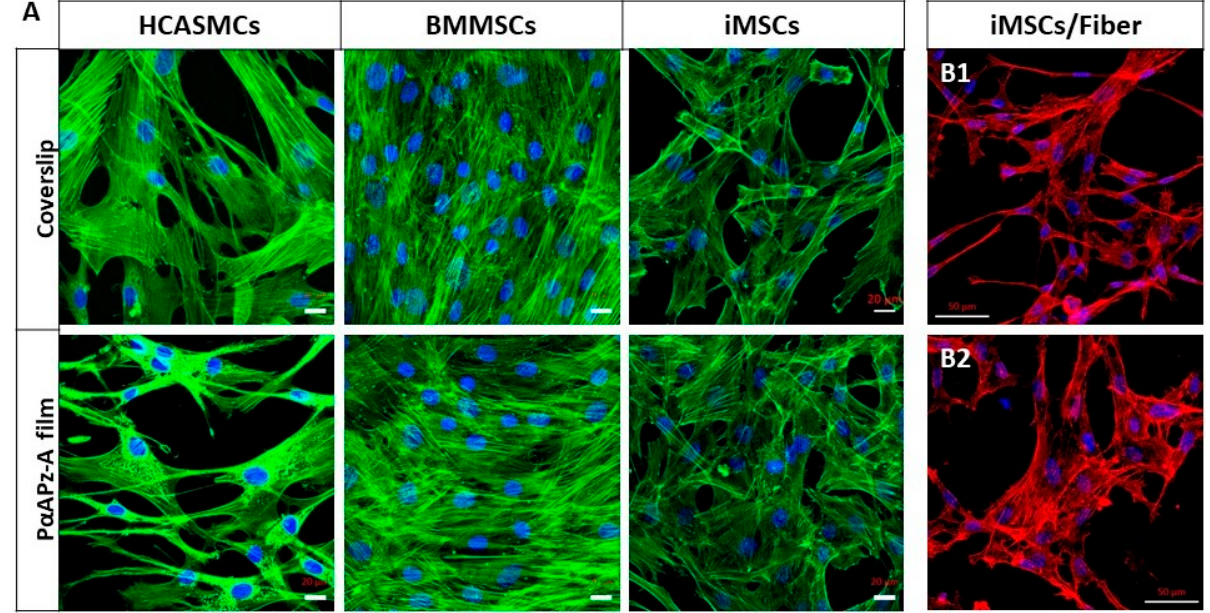
Figure 4. ( A ) Fluorescence images of different cell types on P α APz-A films and on coverslips. After 3 days of culture, F-actin is labeled by Phalloidin in green, and nuclei are labeled by DAPI in blue. Scale bar = 20 µm. ( B1 , B2 ) Fluorescence images of iMSCs after 2 days ( B1 ) and 4 days ( B2 ) of culture on P α APz-A electrospun fibrous mats. Red channel is F-actin, and nuclei are labeled by DAPI in blue. Scale bar = 50 µm.